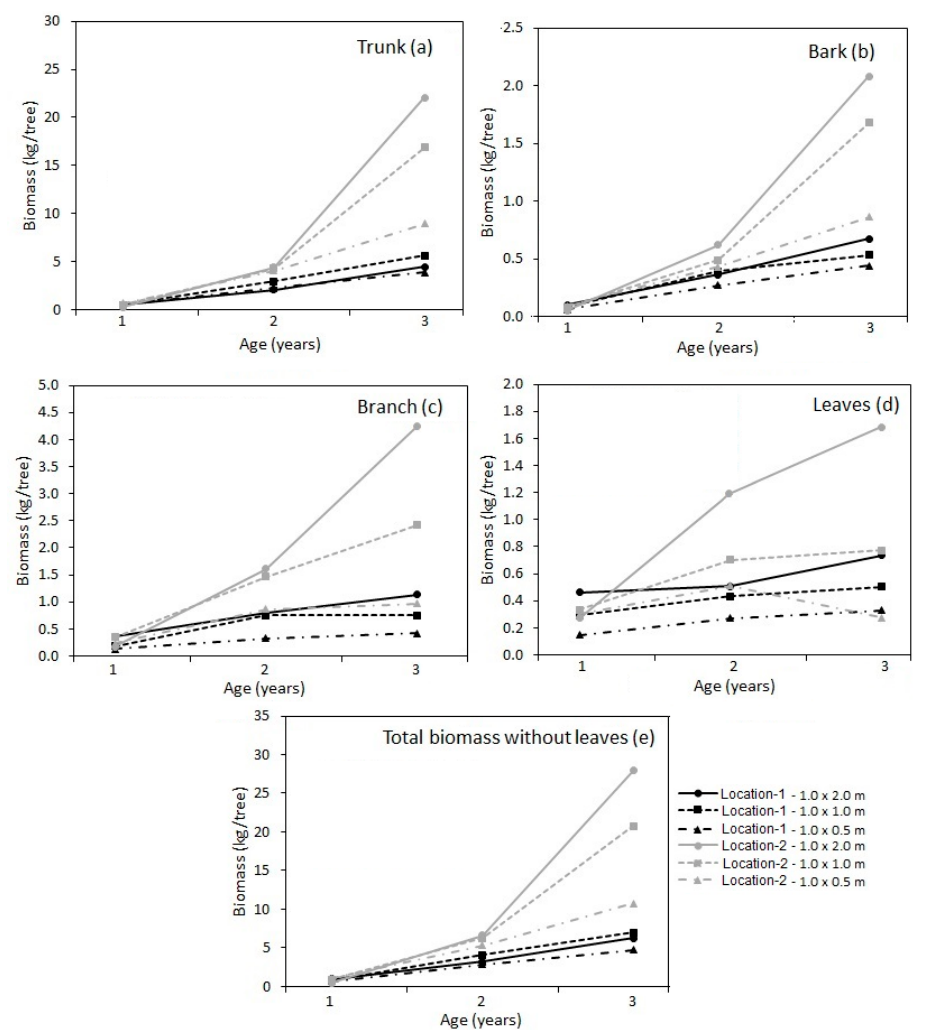
Figure 2. Biomass distribution in the trunk ( a ), in the bark ( b ), in the branch ( c ), leaves ( d ) and total biomass without leaves ( e ) per tree in short rotation of Gmelina arborea plantations in two different locations in Costa Rica.